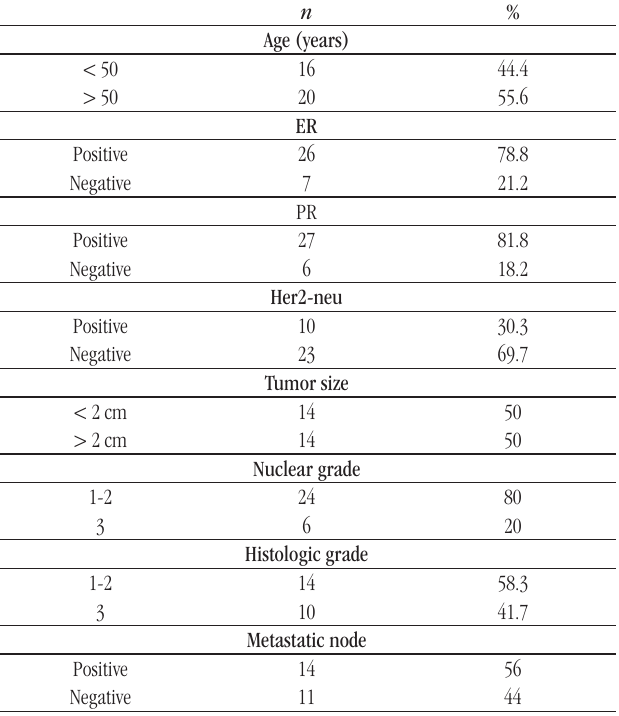
TABLE 1 – Clinical features of tumors from breast cancer patients who participated in the study